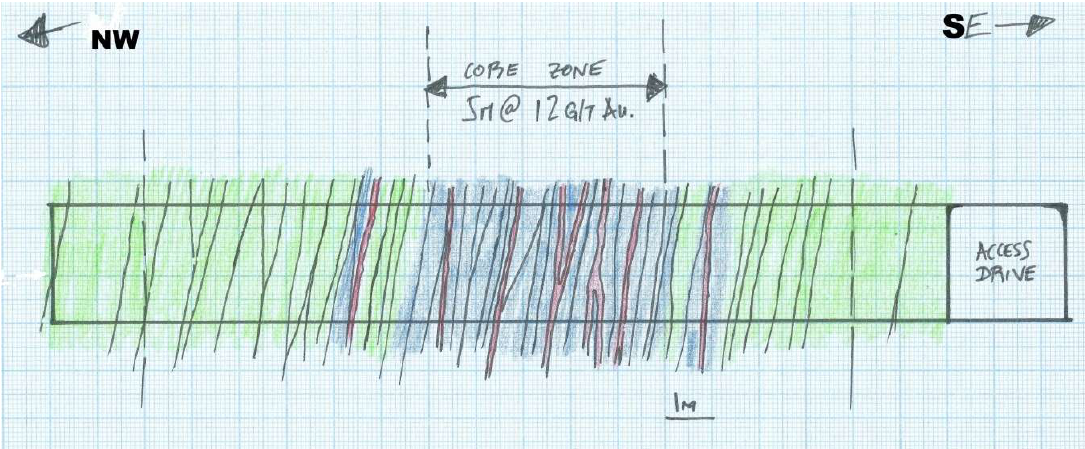
Figure 1. Original geological field sketch of cross-cut #2 through the SVZ (XC.2; see Figure 2) NE wall. Green: weak to moderate silicification; and Blue: strong silicification. Grades from wall channel samples.